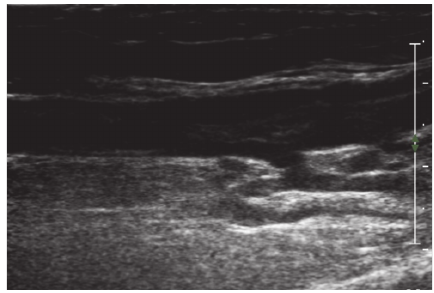
Figure 1: Right upper extremity ultrasound of a 67-year-old man revealing acute venous thrombosis in the brachial vein and periph- eral axillary vein with acute superficial thrombosis in the right basilica vein.